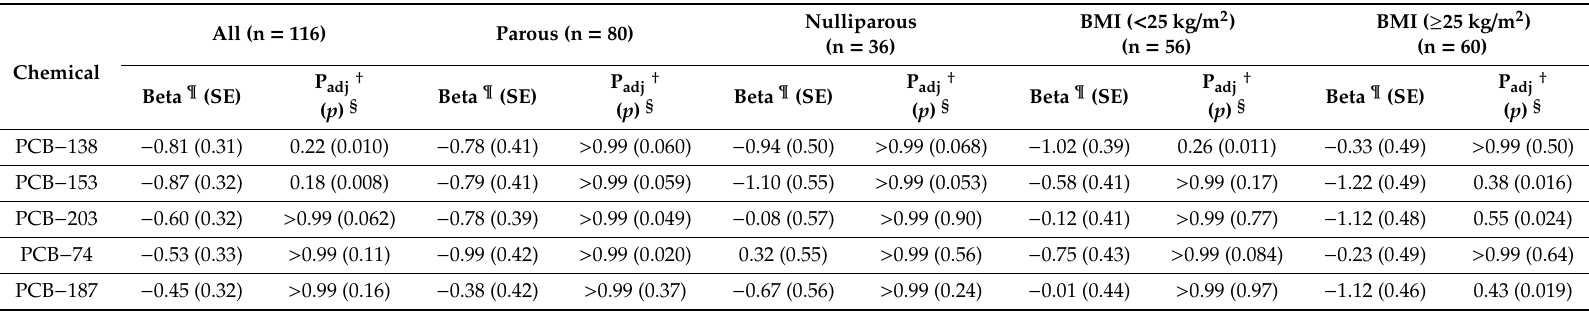
Table 2. Association between square-root-transformed mammographic density (%) and chemicals in all participants and in any of the subgroups based on parity and BMI. Results are presented for chemicals with a p- value < 0.05 in any of the subgroup or overall analyses before correcting for multiple testing